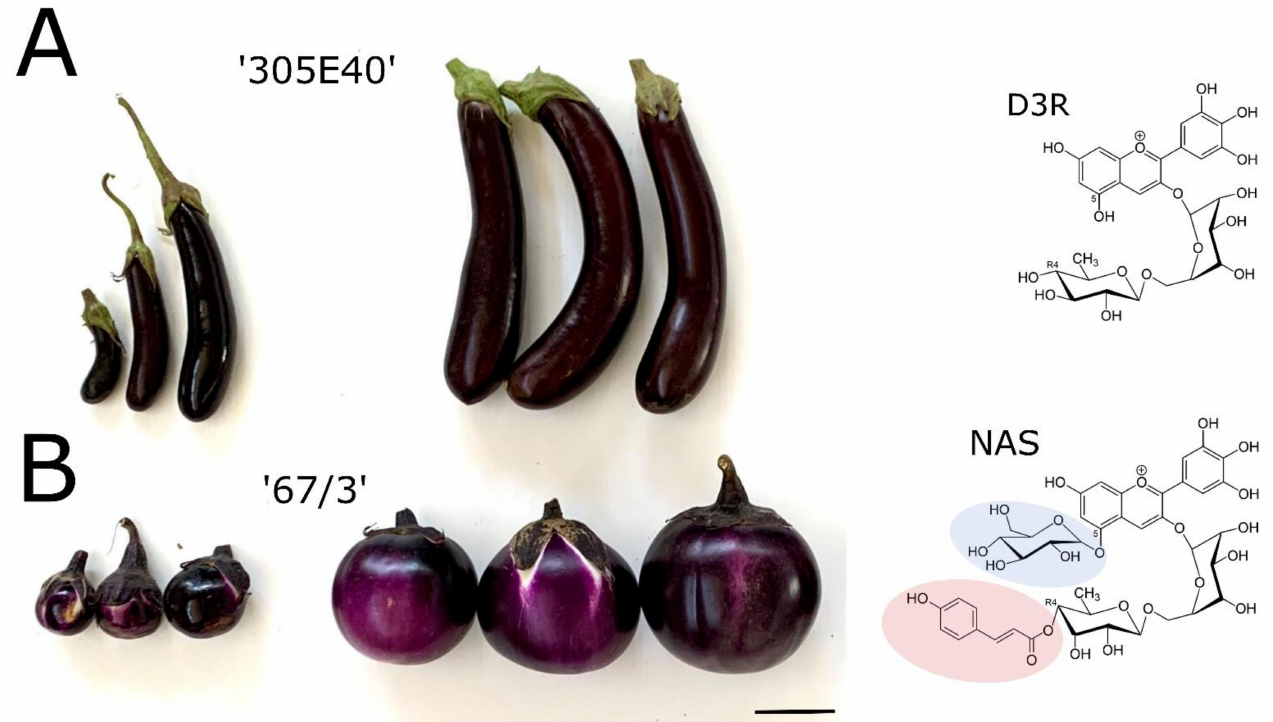
Figure 1. Phenotypic features of ‘67/3’ and ‘305E40’ fruits. ( A ) Berries of ‘305E40’ (purple) and chemical structure of delphinidin-3-rutinoside (D3R). ( B ) Berries of ‘67/3’ (lilac) and chemical structure of delphinidin-3-[ p -coumaroylrutinoside]- 5-glucoside (NAS). The differences between D3R and NAS are shaded in pink ( p -coumaroyl acylation of the rutinose residue) and in blue (5-O-glucosylation). For each eggplant line: on the left, young unripe berries (stage A); on the right, commercially mature berries (stage B); scale bar: 5